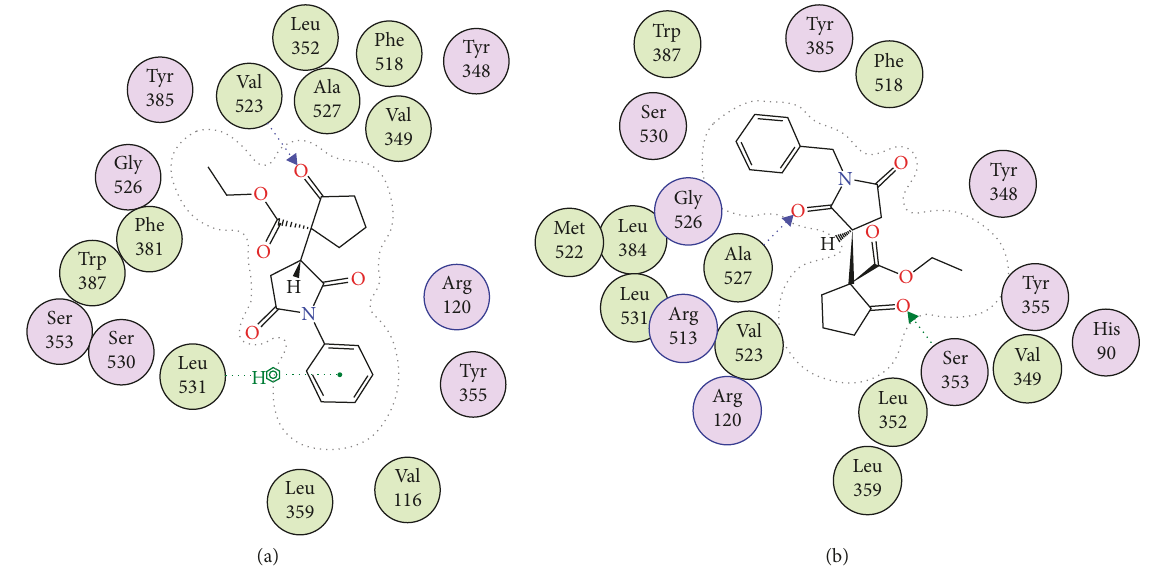
Figure 7: 2D (two-dimensional) binding interaction pattern of compounds (a) A and (b) B in the binding site of